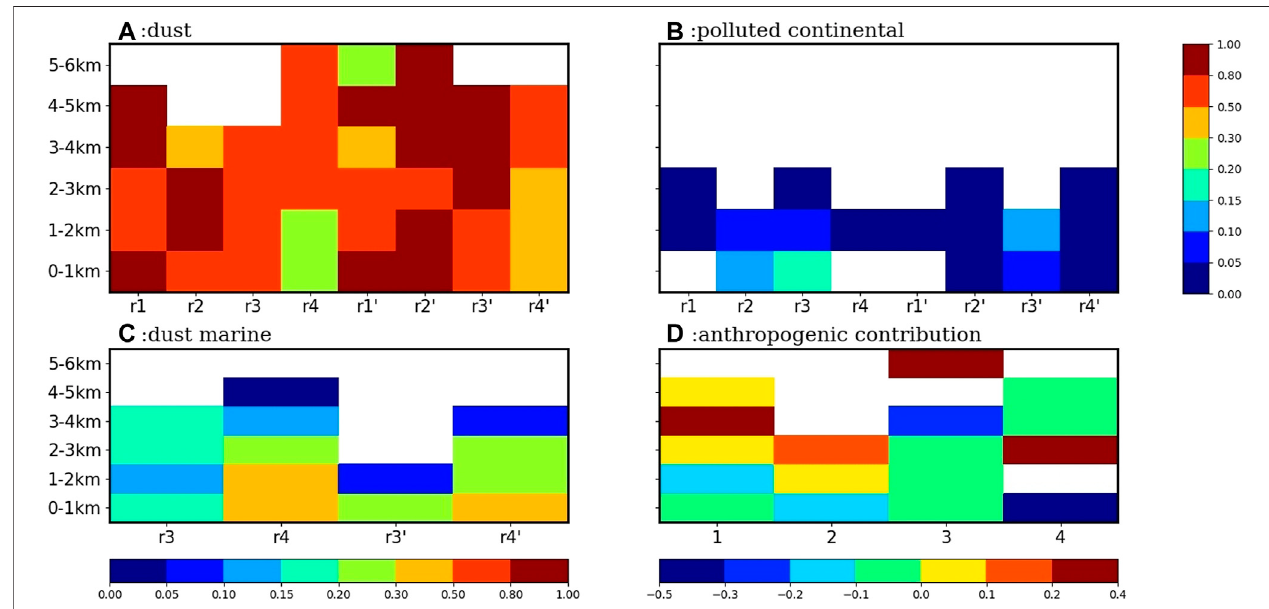
FIGURE13| Changesinthepercentofthedustaerosols (A) ,pollutedcontinental (B) ,dustmarine (C) andelevatedsmoke (D) atdifferentheightin2018(r1,r2,r3, r4) and 2020 (r1 ′ , r2 ′ , r3 ′ , r4 ′ ). And the abscissa in Figure (D) represents the four orbits from west to east.